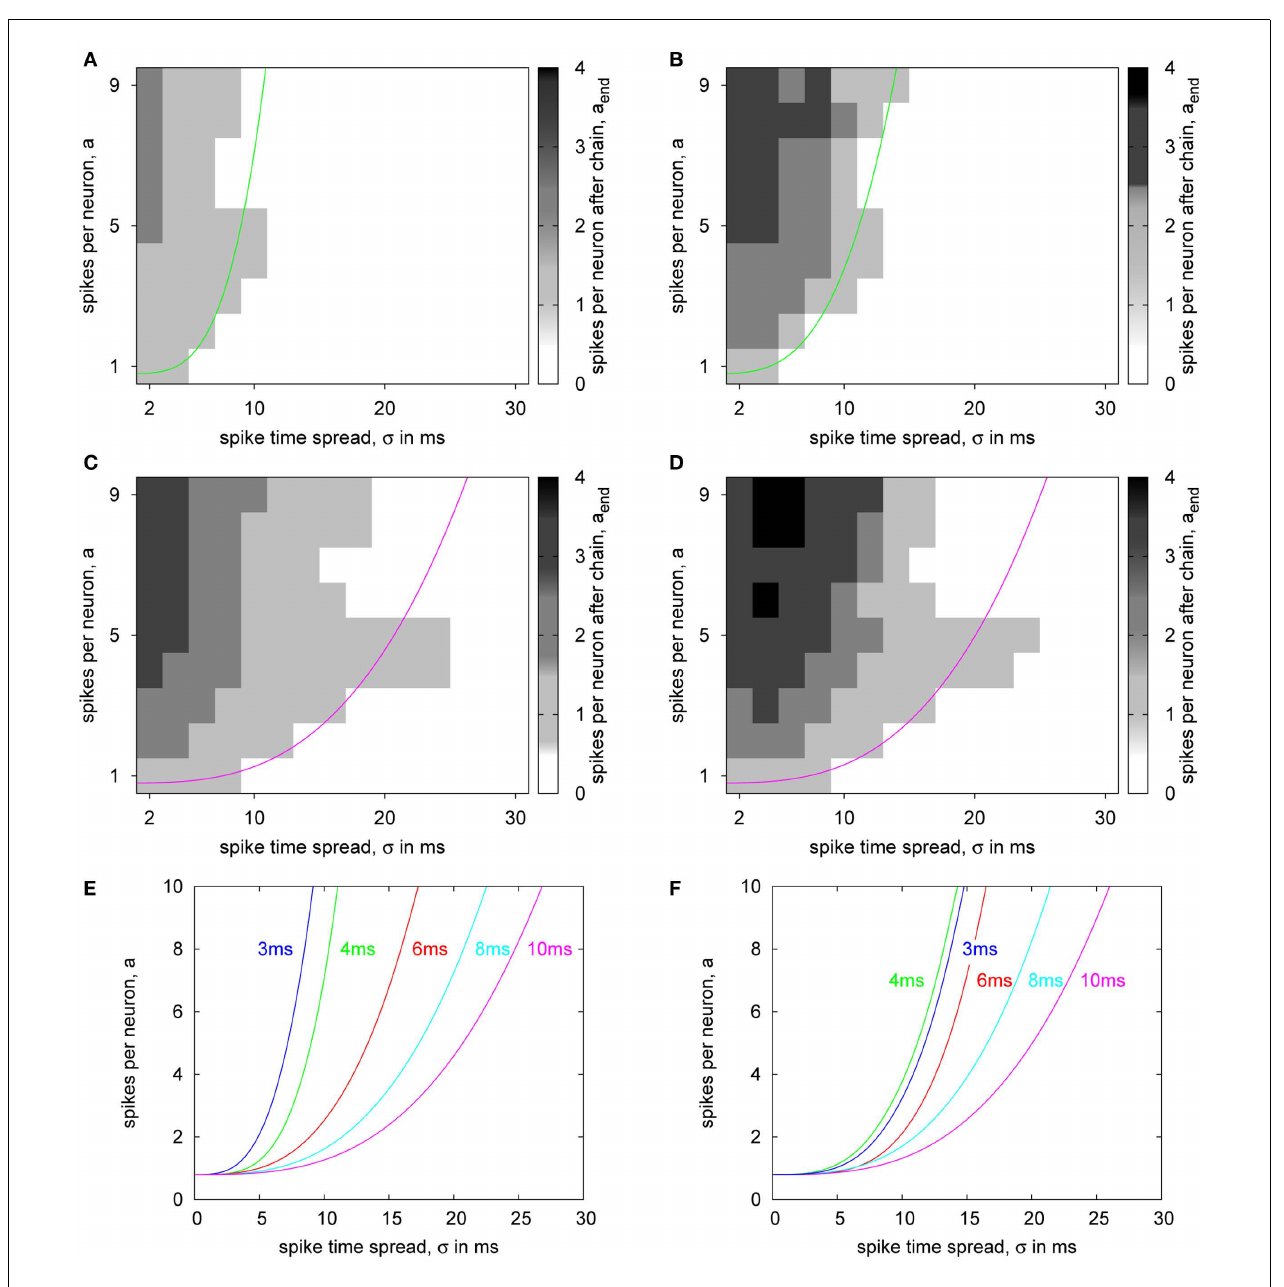
and 10ms (C,D) .The solid lines indicate the fitted separatrix between successful transmission of the spike volley to the end of the chain and diminishing activity. (E,F) Separatrices for different delay settings with ideal (E) and hardware (F) transmission.